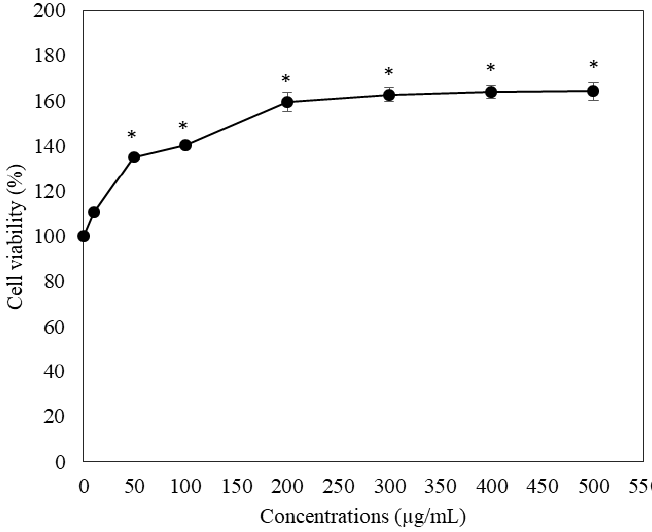
Figure 3. MTT test-based viability of RAW264.7 macrophage cells treated with 50% ethanolic extracts of P. odoratum Lour. cv. Pakphai leaves. Data obtained from three independent experiments are expressed as mean ± SEM values. Accordingly, * p < 0.05 was considered significant when compared with untreated cells. MTT = 3-(4,5-dimethyl-2-thiazolyl)-2,5-diphenyl-2-H-tetrazolium bromide, SEM = standard error of the mean values.